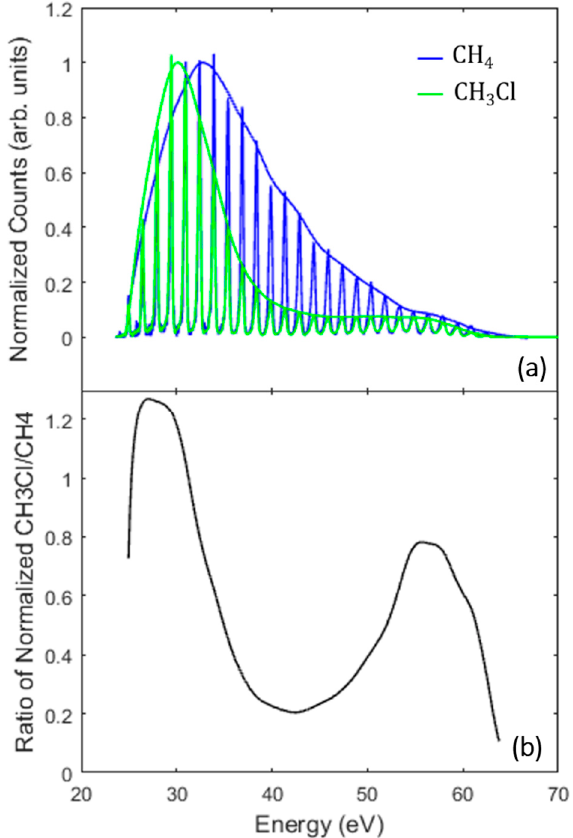
Figure 3. Influence of the methyl chloride Cooper minimum (CM) on the spectral intensity relative to methane. ( a ) Normalized spectra were taken in sequence with identical harmonic generation conditions for the intensity comparison of methane (blue) and methyl chloride (green); ( b ) The ratio of normalized spectra from ( a ) shows the relative minimum in amplitude. Because the laser field was held constant and the spectra were normalized, the difference was attributable exclusively to the chlorine substitution.